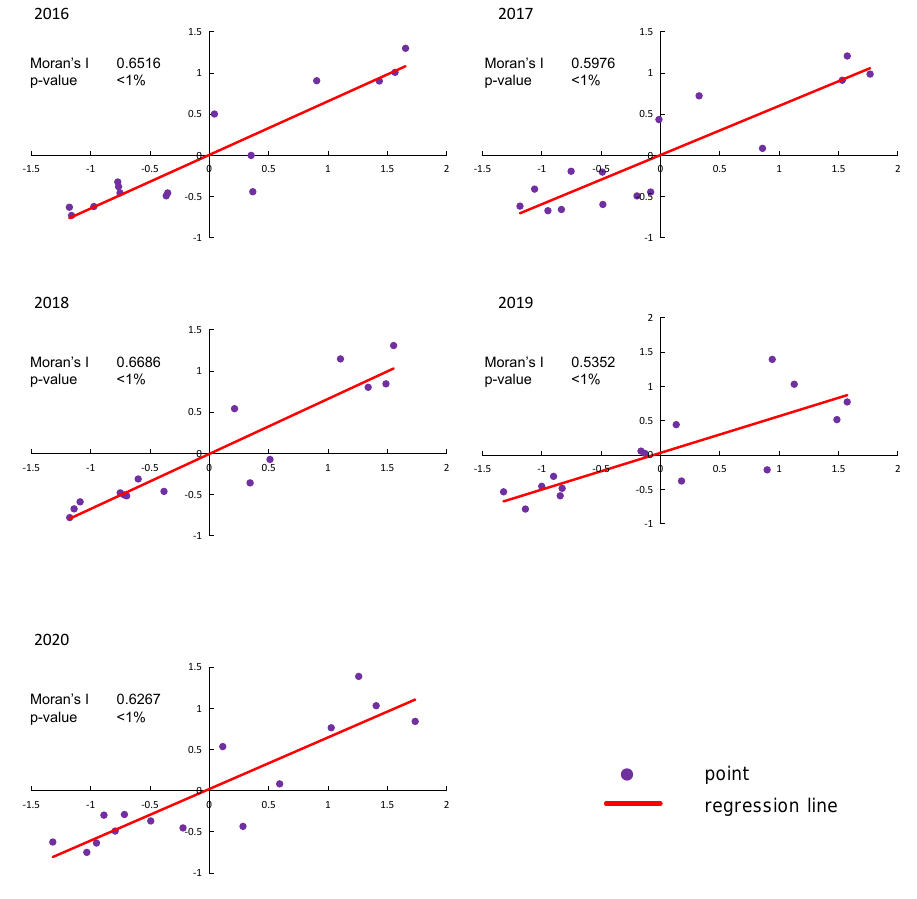
Figure 19. Moran scatter